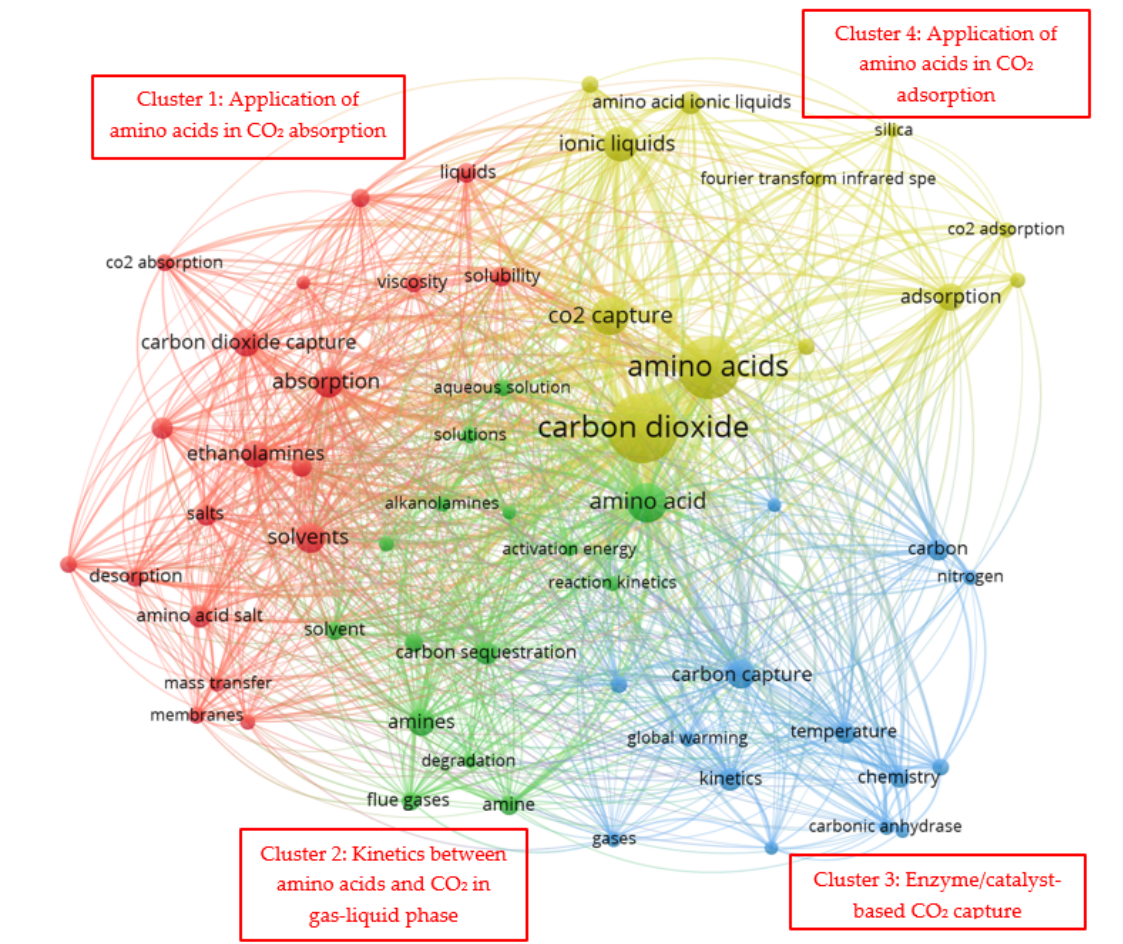
Figure 3. Co-occurrence of keywords network analysis. Table 4. Top ten most-cited articles in the field of amino acid-based adsorbents for CO 2